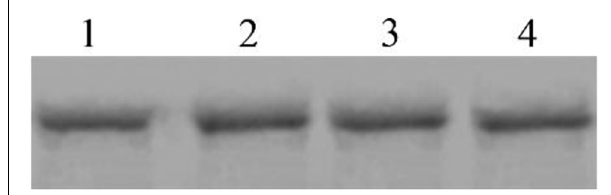
FIGURE 8 | Competitive determination of Cry8Ca between biotinylated Sip binding in C. bowringi BBMV. 1: 100 nM biotinylated Sip, 2–4: Biotinylated Sip + Cry8Ca in 10-, 15-, and 20-fold excess,